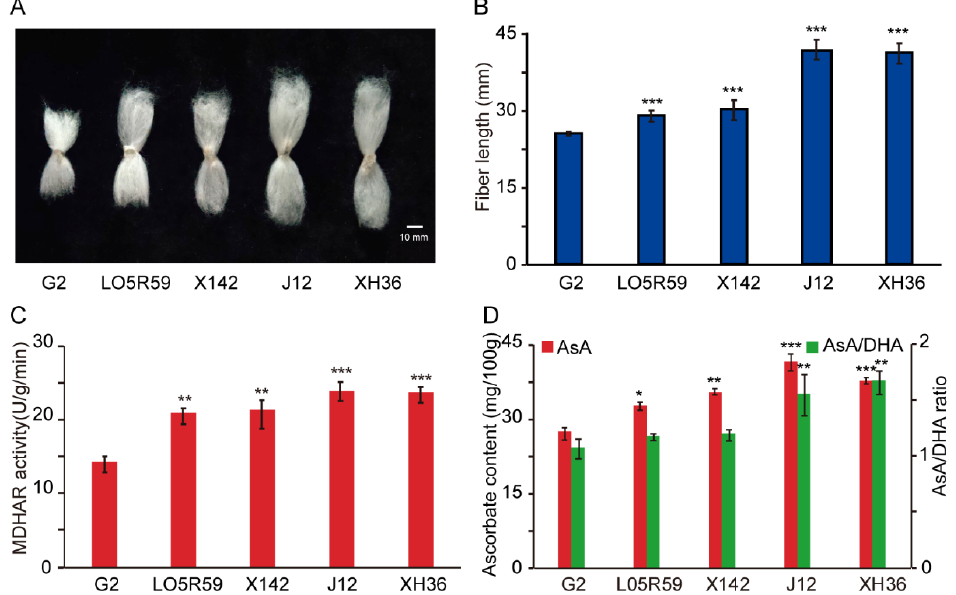
Figure 6. Correlation analysis between GhMDHAR expression and fiber elongation development. fiber LO5R59 and X142, and long-fiber J12 and XH36, were selected for analysis of MDHAR activity, AsA content and AsA/DHA ratio. Phenotype ( A ) and fiber length statistics ( B ) of mature fibers of different fiber-length cotton cultivars. ( C ) MDHAR enzyme activity measurement of fibers of different fiber-length cotton cultivars. The 15-DPA fibers of presented different cotton cultivars were collected and used for MDHAR activity analysis. ( D ) Determination of AsA content and AsA/DHA ratio in fibers of different fiber-length cotton cultivars. The 15-DPA fibers of different cotton cultivars were utilized for AsA content and AsA/DHA ratio analysis. The values of the short-length cultivar G2 were selected as control for statistics difference analysis by one-way ANOVA. Asterisks indicate the significant differences, * p < 0.05, ** p < 0.01, *** p <